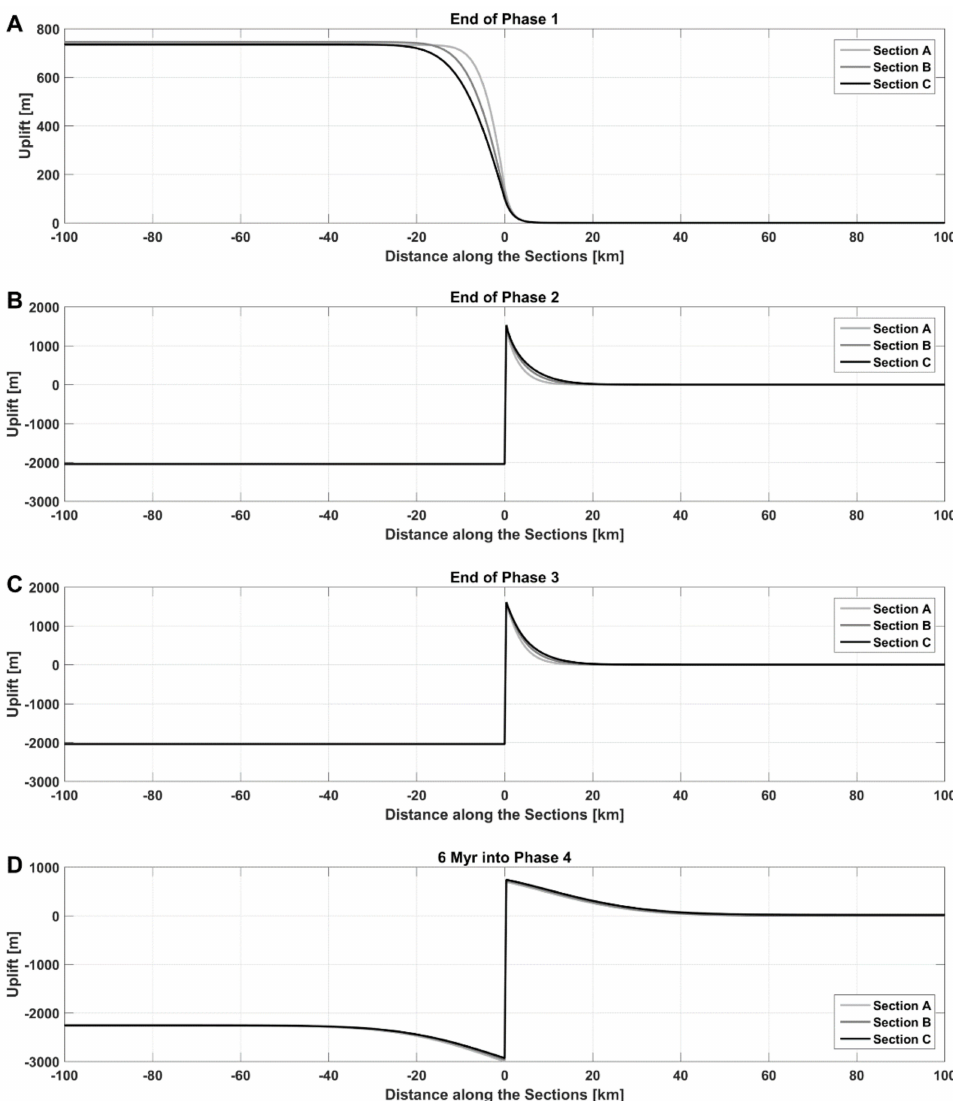
Figure 11. Uplift generated in the lithosphere along sections A, B, and C at the end of various phases along the transform margin for a fast spreading system. Sub-figures A to D denote transform phases 1 to 4 (see